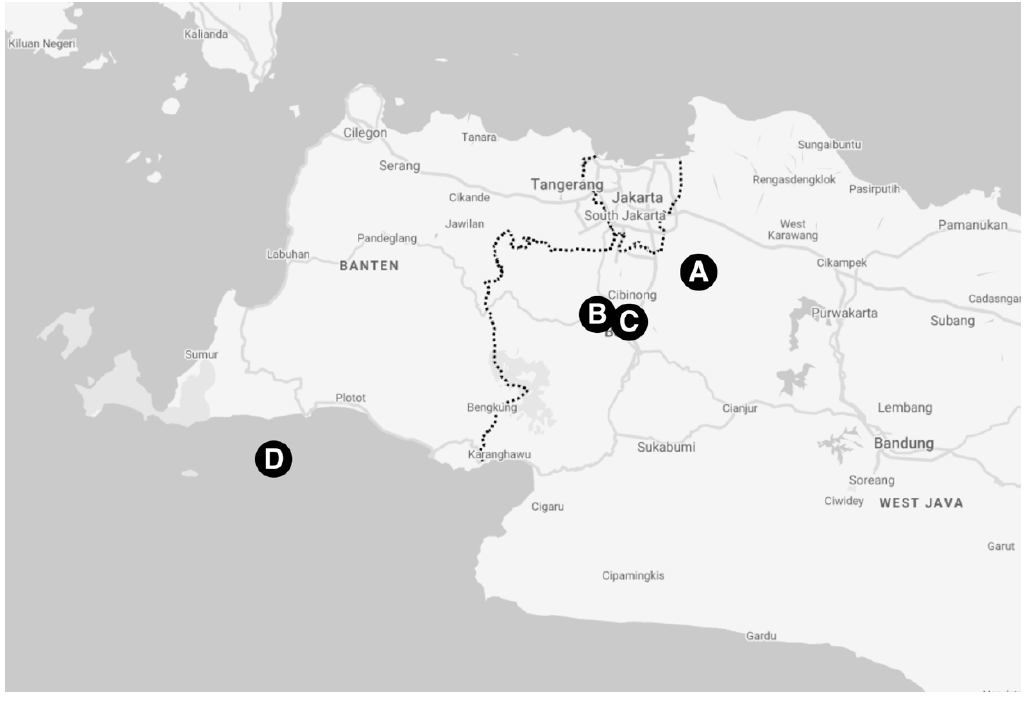
Figure 1. Map of western part of Java pointing NHP facilities in this study: Jonggol (A), Darmaga (B), Lodaya (C), and Tinjil Island (D).